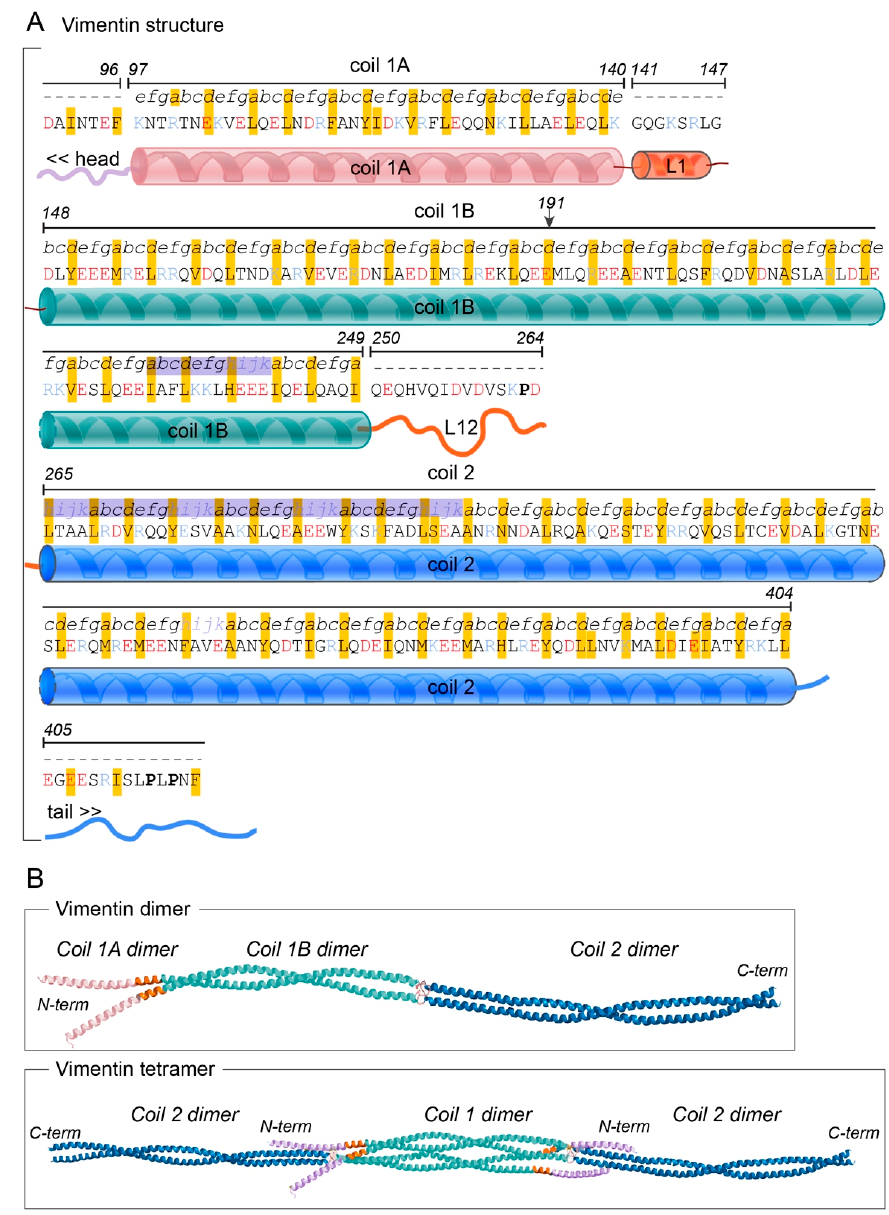
Figure 1. ( A ) The amino acid sequence of vimentin rod domain, with the amino acid position in the sequence indicated above the one-letter code. Heptad (not coloured) and hendecad (violet) motifs are indicated. Residues predicted to be buried in the hydrophobic core are highlighted in yellow. The coil 1A, linker 1, coil 1B, coil 2 structures are indicated with pink, red, violet, and blue, respectively. ( B ) Schematic structure of a vimentin dimer (top) and tetramer (bottom) showing the antiparallel association of two coiled coil dimers, with the structures indicated with colours as in A. Each dimer is formed by a pair of parallel chains. The figure is adapted from Figure 4 in Chernyatina, PNAS 2015 [36], and based on data by Chernyatina, PNAS 2012 [37].